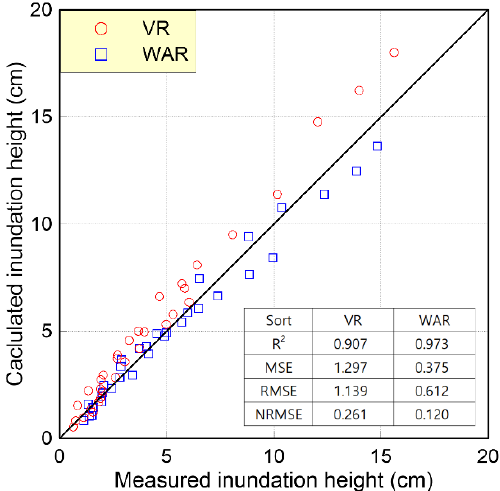
Figure 13. Spatial distributions of measured and calculated water surface elevations around the WAR (left: Run-4 ( 𝐴 0 = 8.2 cm , 𝜀 = 0.18 ), right: Run-10 ( 𝐴 0 = 18.7 cm , 𝜀 = 0.4 )) — comparison be- tween the measured and calculated results.